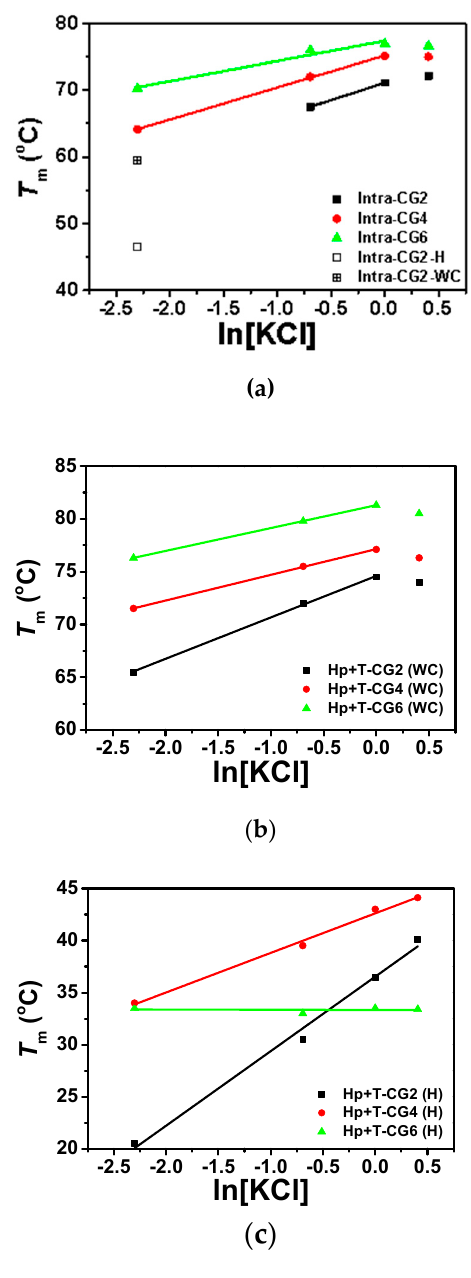
Figure 5. The plot of T m vs. ln[KCl] of ( a ) intramolecular triplexes ( T m of Intra-CG2 in 0.1 M KCl was separately plotted with Hoogsteen base pairs and Watson – Crick base pairs displayed as open square and + open square , respectively) , ( b ) Watson–Crick base pairs of intermolecular triplexes, and ( c ) Hoogsteen base pairs of intermolecular triplexes in the buffer containing 50 mM MES at pH 6.0.